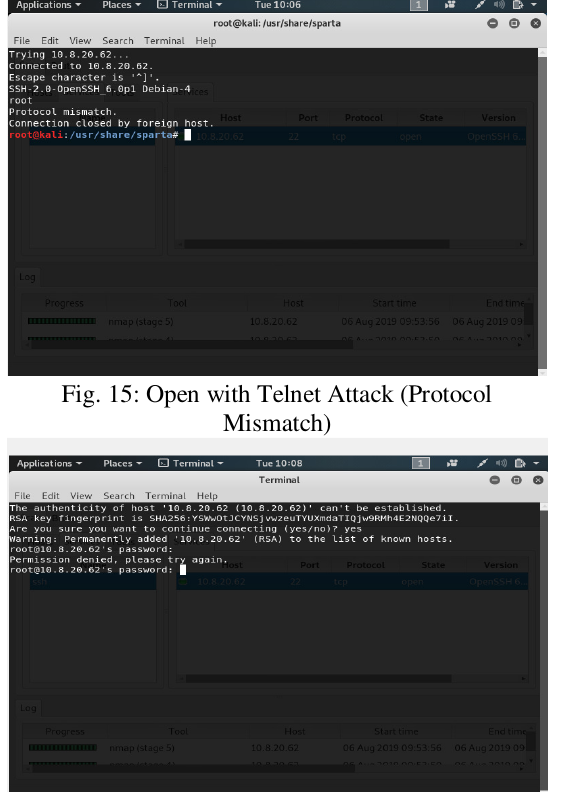
Fig. 16: Open with SSH Client (as Root) Attack (Permission